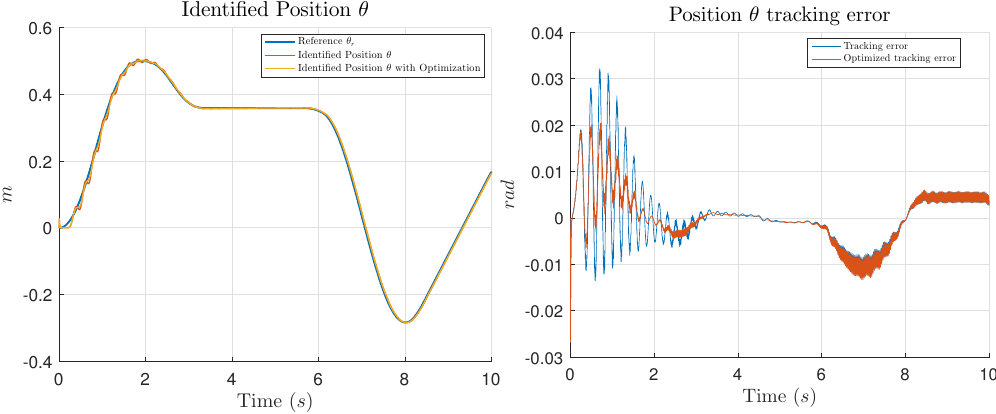
Figure 8. Tracking of θ ( left ) and error comparison ( right ) for the simulation